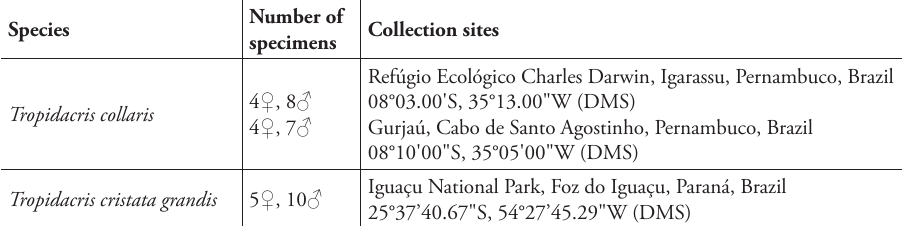
Table 1. Collection sites of studied species.